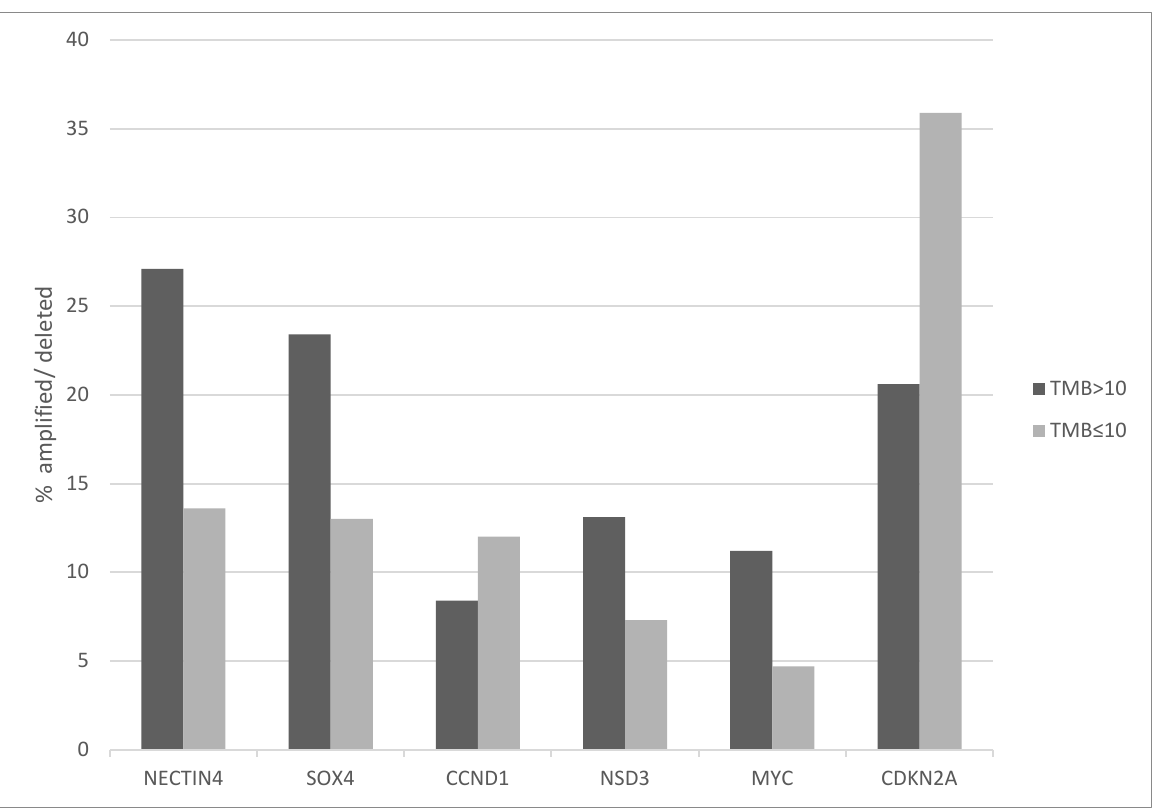
Figure 5. Aneuploidy Scores (AS) of above or below 4 in bladder carcinomas according to TMB. High TMB group: TMB > 10 mutations/MB, low TMB group: TMB ≤ 10 mutation/MB. Data are from TCGA. TMB: Tumor Mutation Burden.